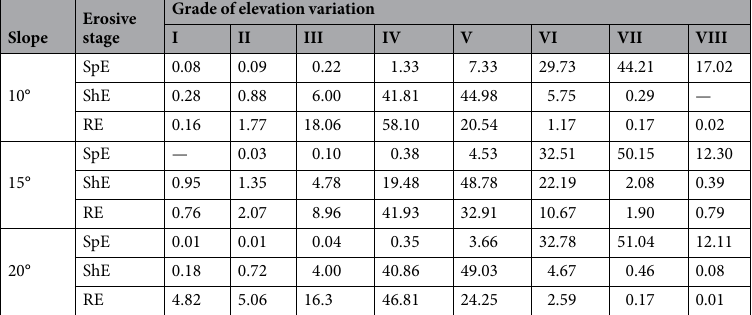
Table 1. Grade distribution of surface elevation variation at different erosive stages.